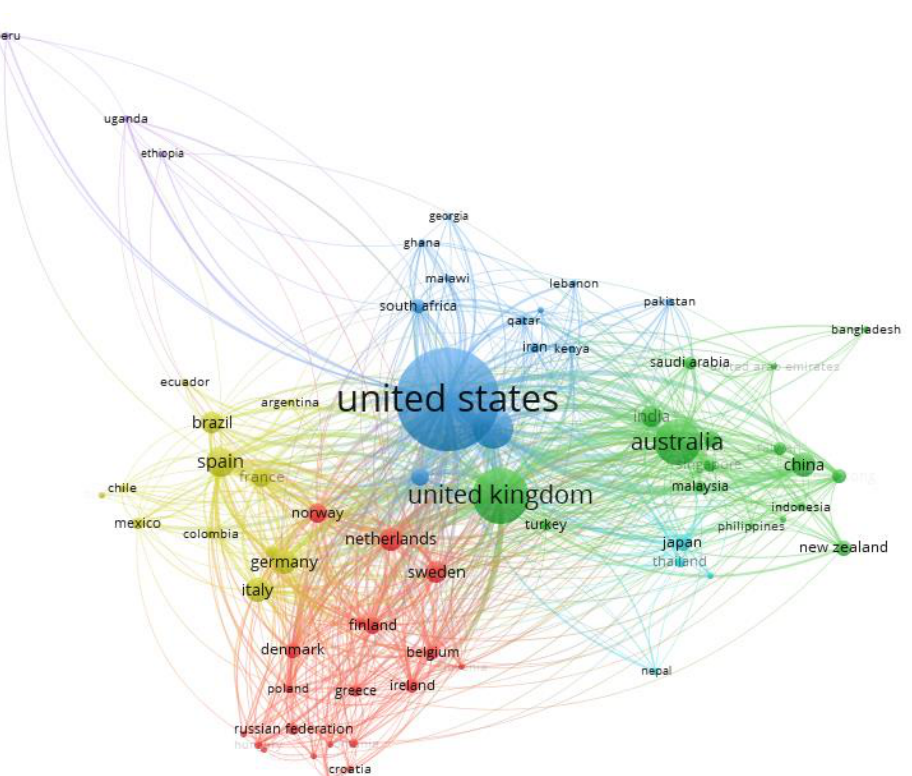
Figure 7. Collaboration among countries.